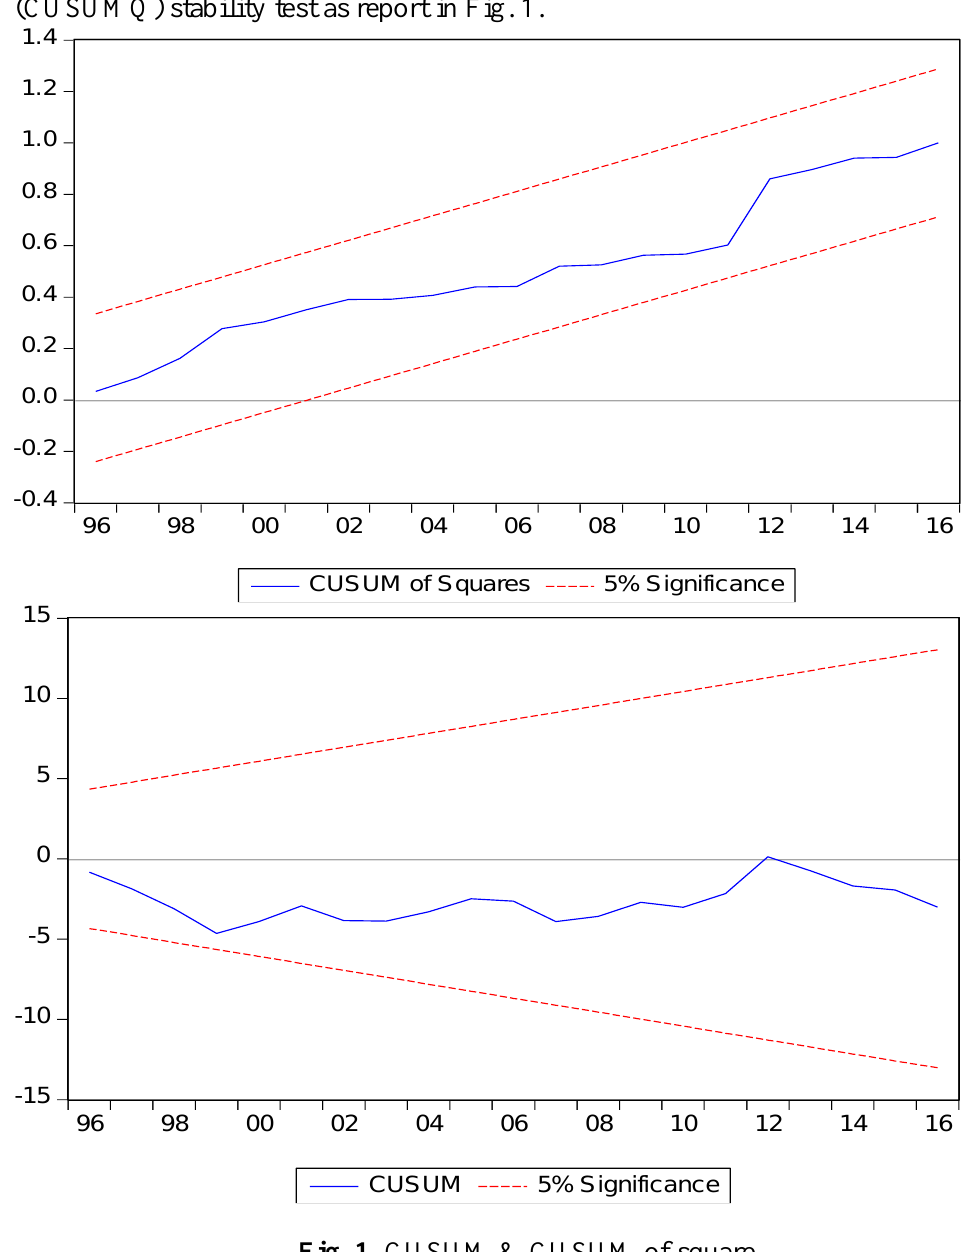
Fig. 1 . CUSUM & CUSUM of